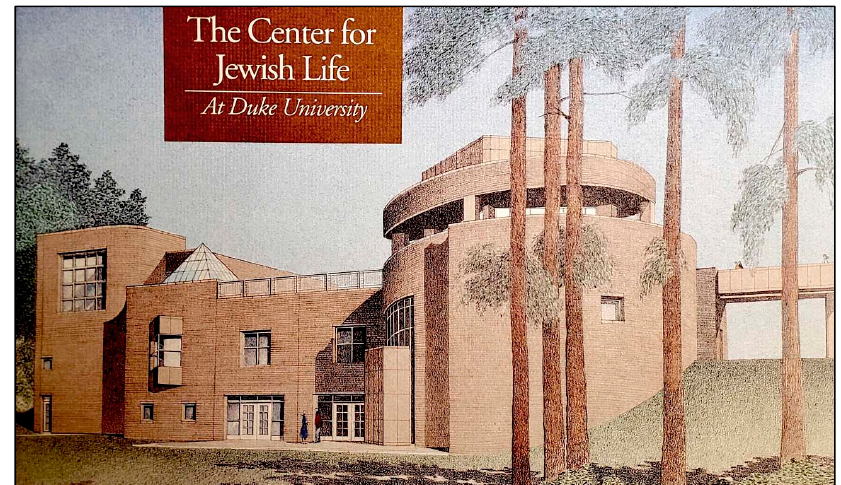
Figure 10. Center for Jewish Life at Duke: original design circa 1990. Image Credit: Gwathmey Siegel Kaufman & Associates Architects LLC, used by permission. Original document courtesy Duke University